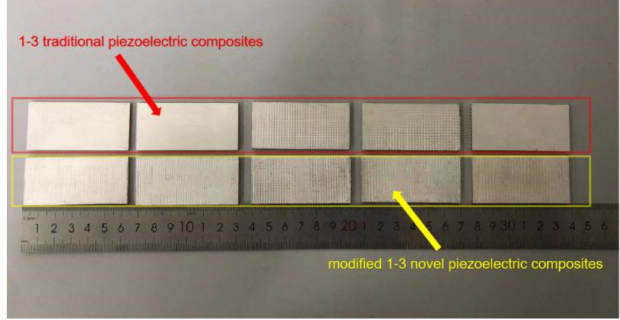
Figure 5. Sample images of two kinds of piezoelectric